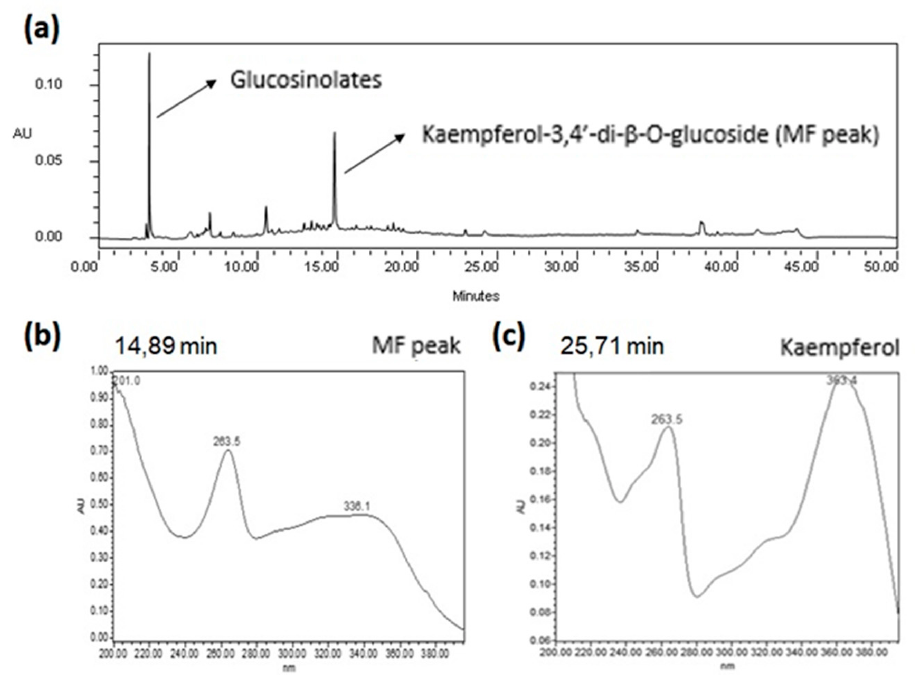
Figure 1. Chromatographic profile of ethanolic extract of Eruca sativa leaves and comparison of UV-spectra of MF peak and kaempferol. ( a ) Chromatogram of the ethanolic extract of Eruca sativa leaves obtained by HPLC-DAD at 264 nm. ( b ) UV spectra of MF peak extracted from chromatogram of Figure 1a. ( c ) UV spectra of kaempferol standard injected independently at the same chromatographic conditions of MF peak.